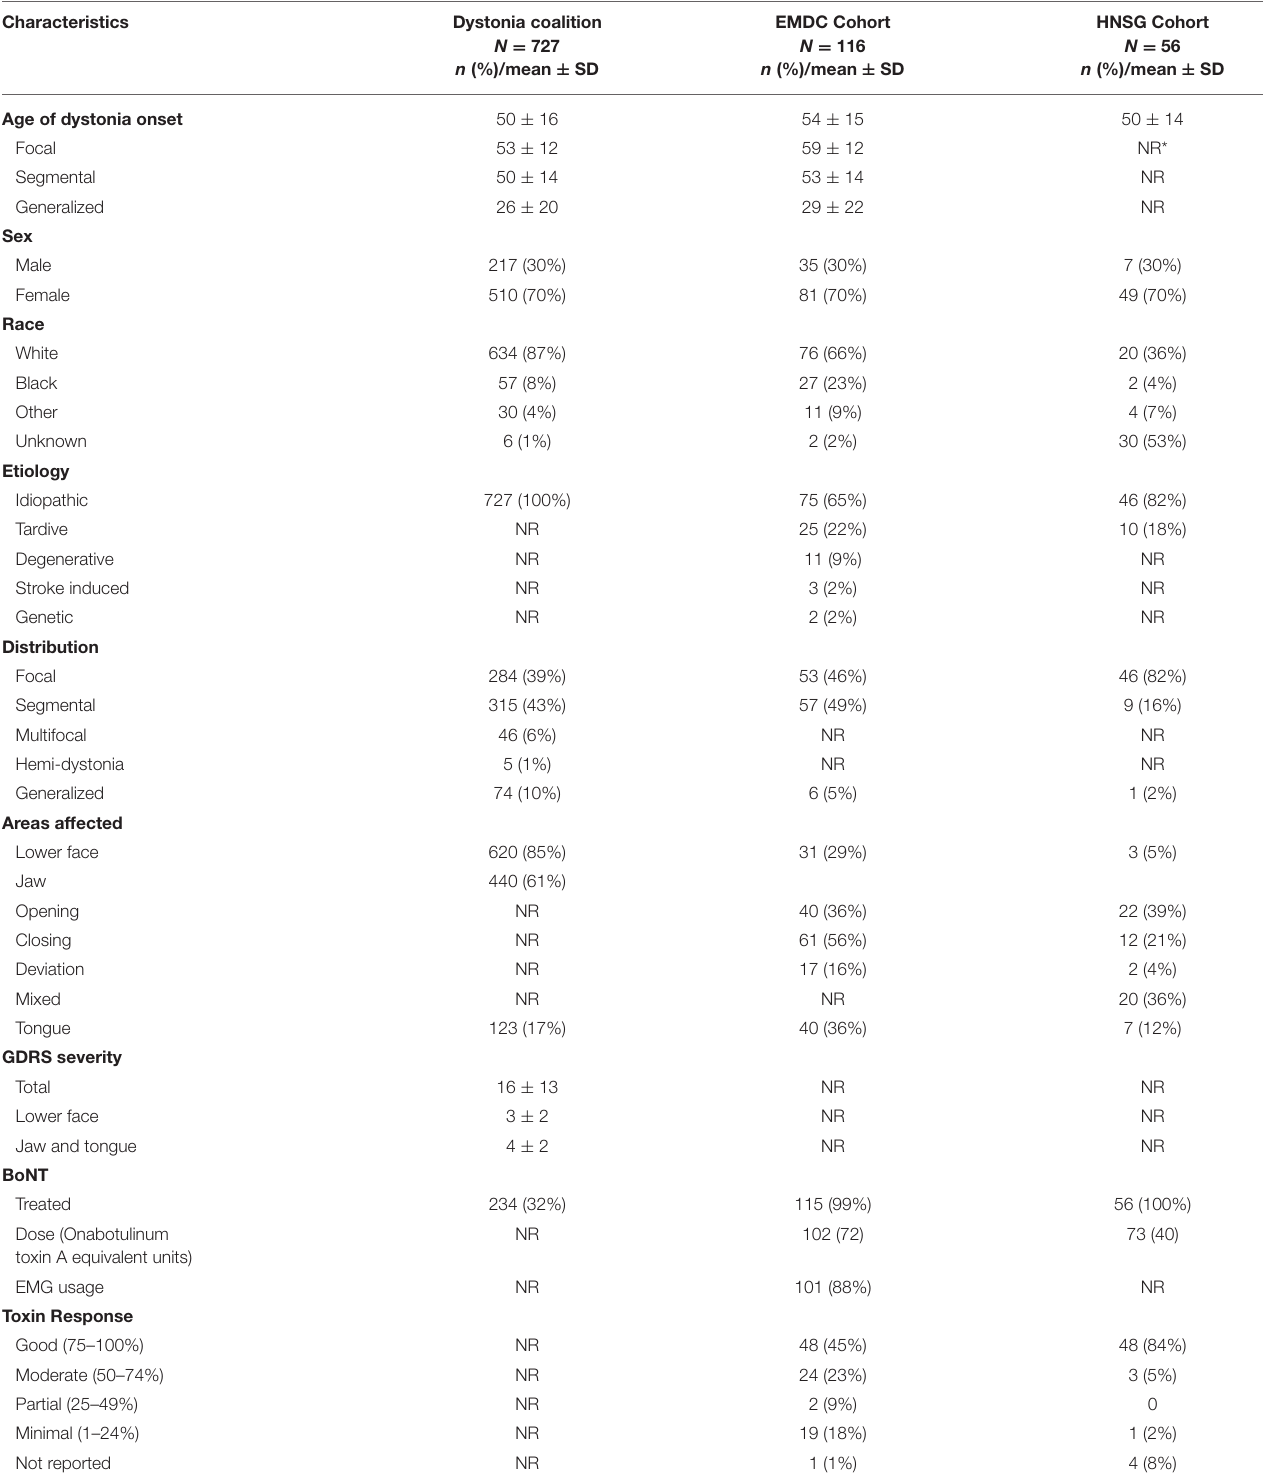
TABLE 2 | Clinical characteristics and treatment response of oromandibular dystonia subjects in the Dystonia Coalition database, EMDC Cohort, and Head and Neck Surgical Group (HNSG) Cohort.